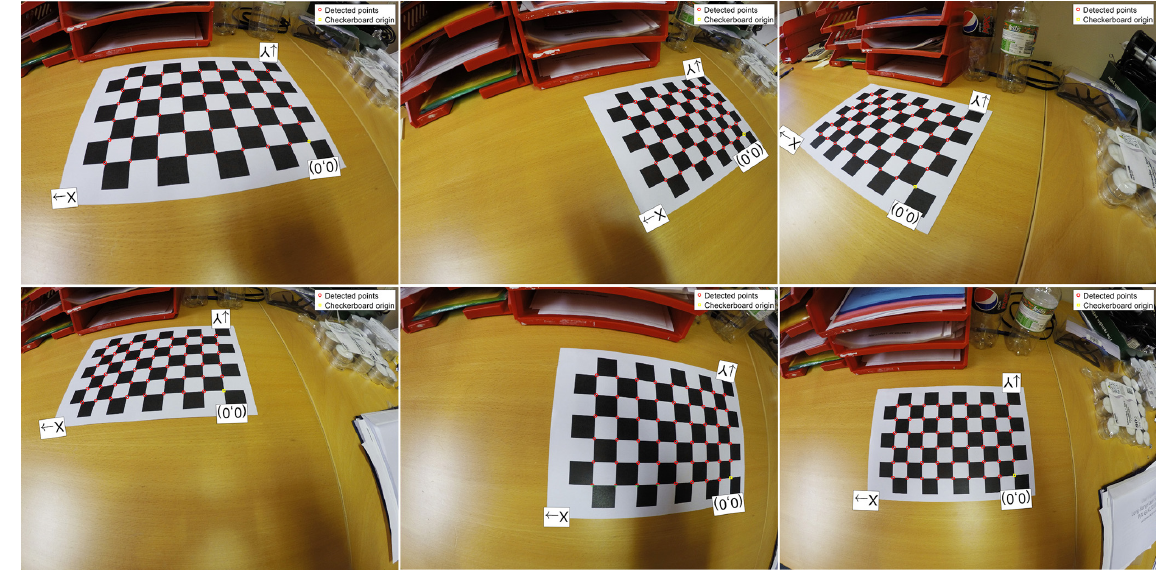
Figure 3. Modeling of lens distortion. Checkboard pattern used for calibrations. Red circles are used to mark automatically detected square corners, while the yellow square marks the origin of the coordinate system. Images of the pattern are taken from 10 to 20 different camera angles.